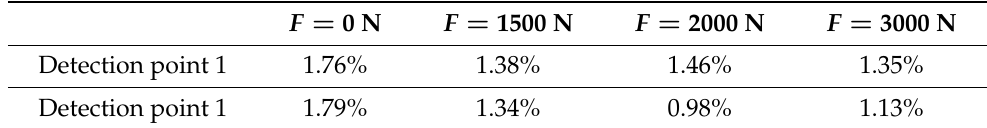
Table 2. Experimental